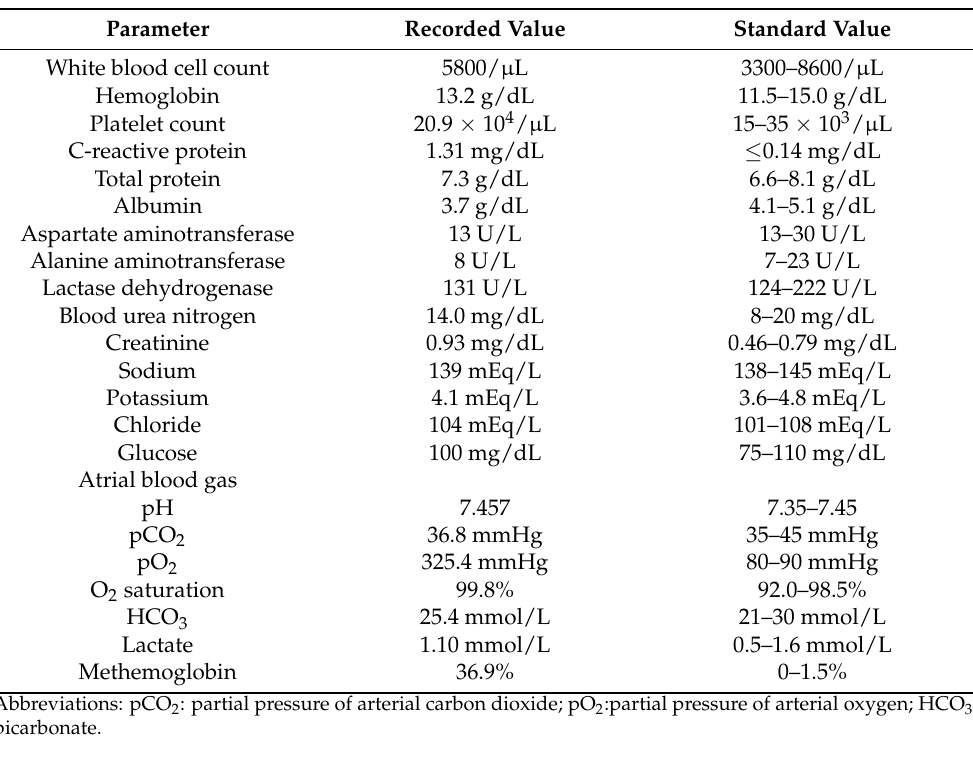
Table 1. Laboratory test results at admission.